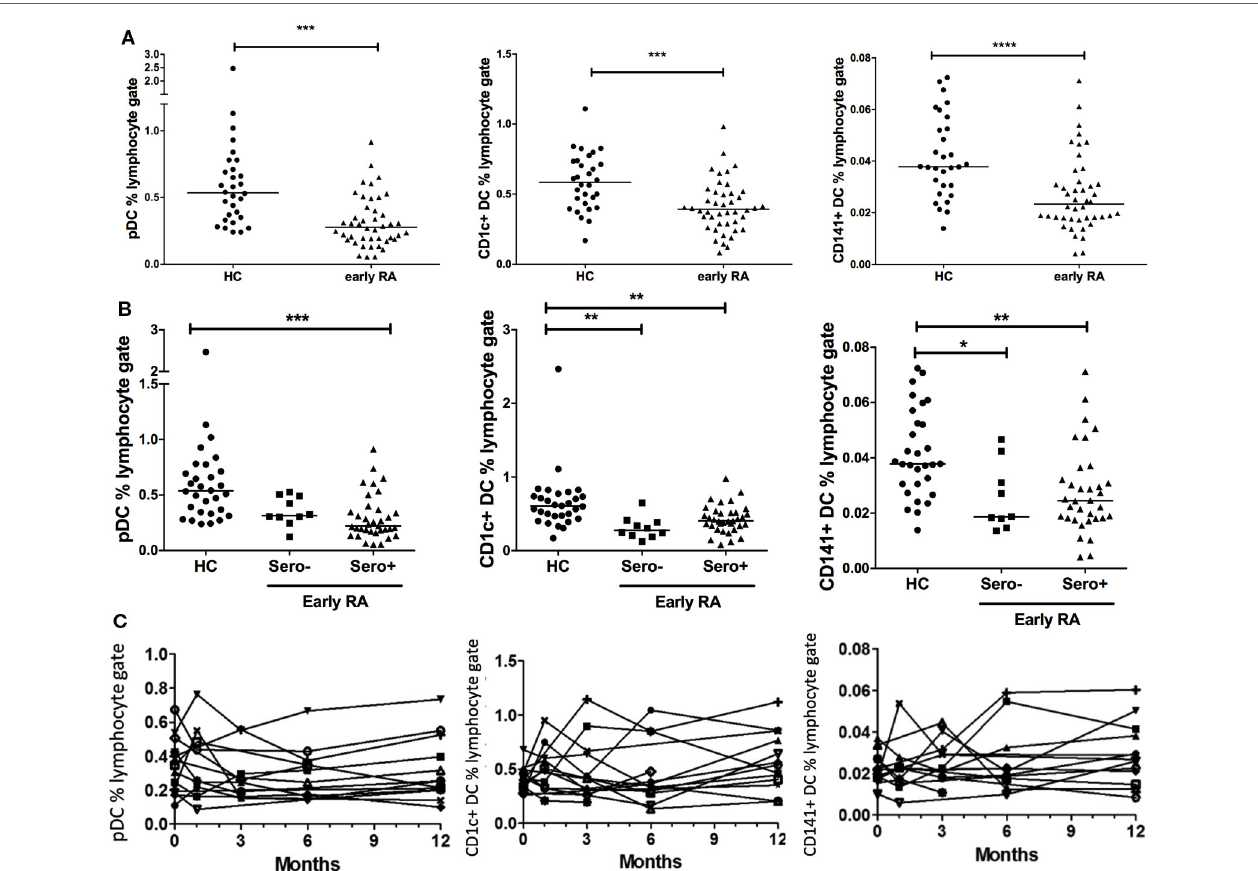
FigUre 1 | Peripheral blood DC frequency is reduced in early rheumatoid arthritis (RA). (a) Peripheral blood plasmacytoid DCs (pDCs), CD1c + , and CD141 + dendritic cells were identified by flow cytometry and recorded as a percentage of the circulating lymphocyte population in early RA patients ( n = 44); and healthy controls ( n = 30). Mann–Whitney U test. (B) The early RA cohort was further split into seropositive (RF + and/or anti-CCP + ) or seronegative (both RF + and anti-CCP − ). One way ANOVA with Tukey’s multiple comparison test. Horizontal lines depict median values. (c) pDC, CD1c + , and CD141 + DC frequencies were enumerated longitudinally in an early RA cohort ( n = 15) at baseline and then 1, 3, 6, and 12 months after diagnosis. Each line represents an individual patient. Wilcoxon signed rank test. * p < 0.05, ** p < 0.01, *** p < 0.001, **** p <